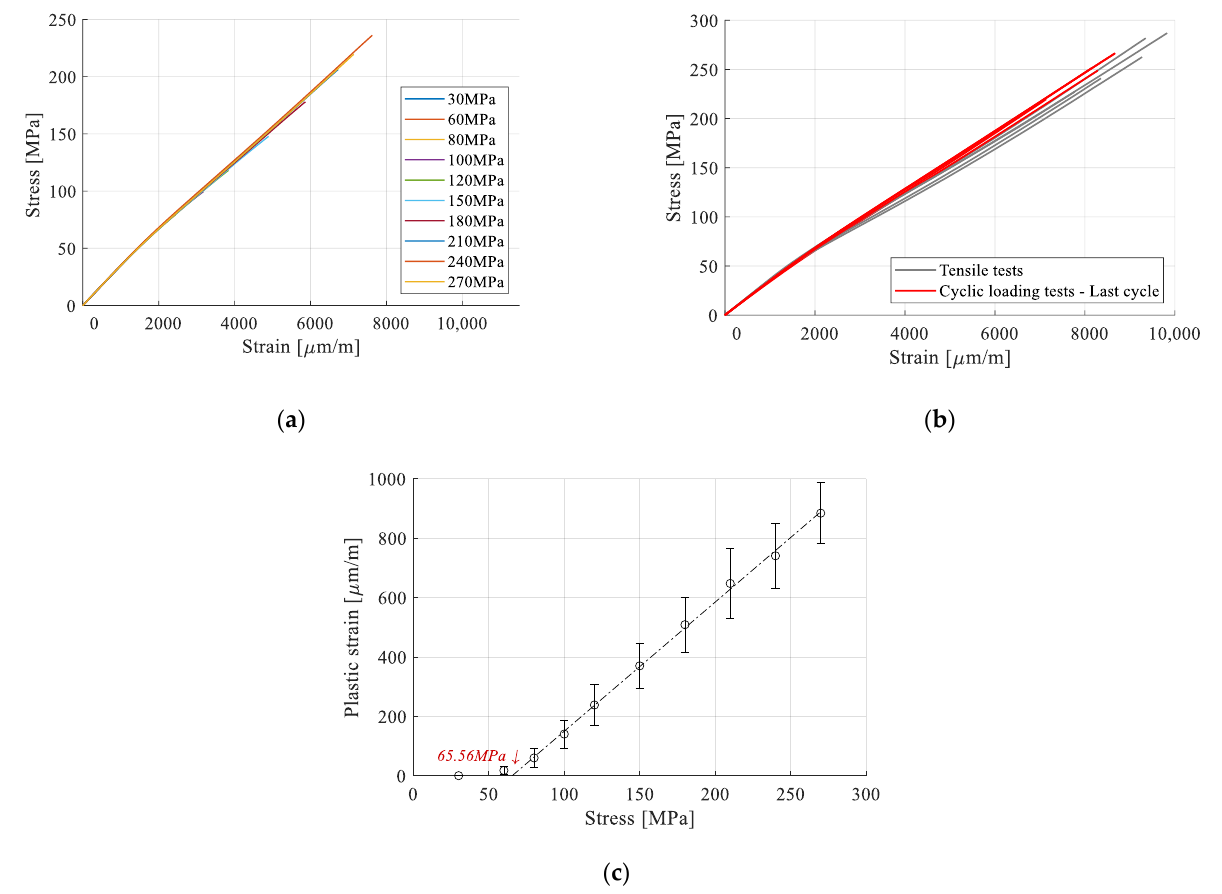
Figure 10. Strain response of a sample subjected to repeated progressive load tests.